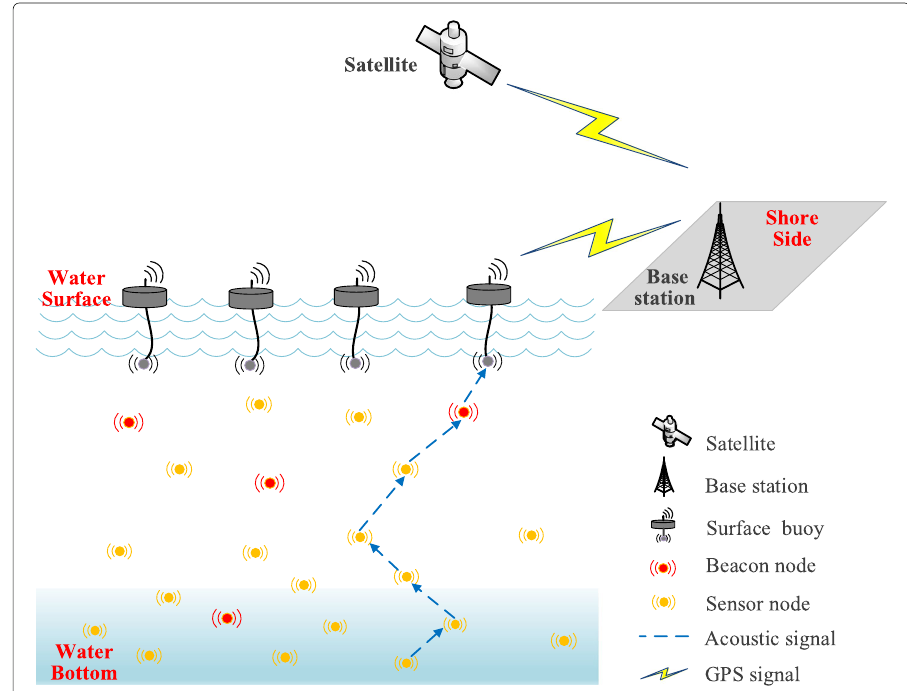
Fig. 1 Network architecture of